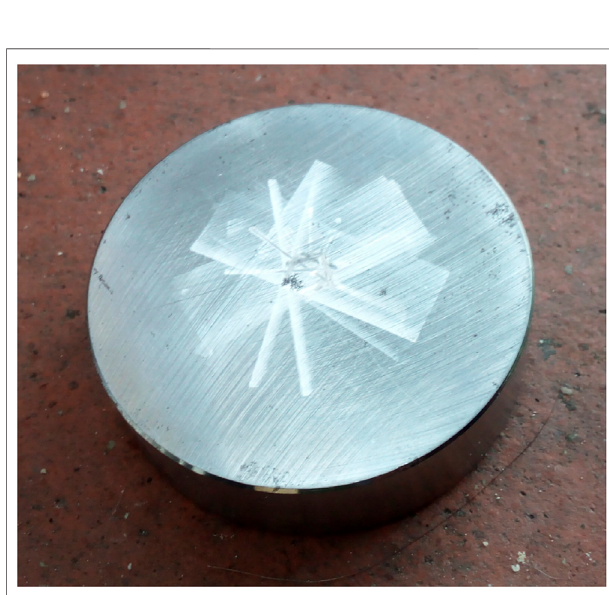
FIGURE 12| Worn surface ofone of the followers used for several